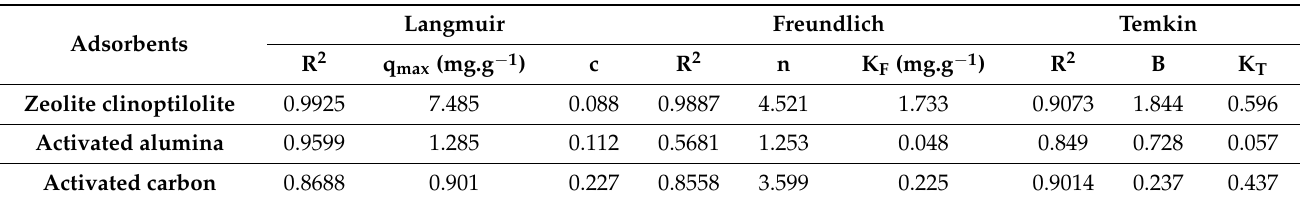
Table 4. Correlation coefficient and constant values of the isotherms for the adsorption of calcium ions by different